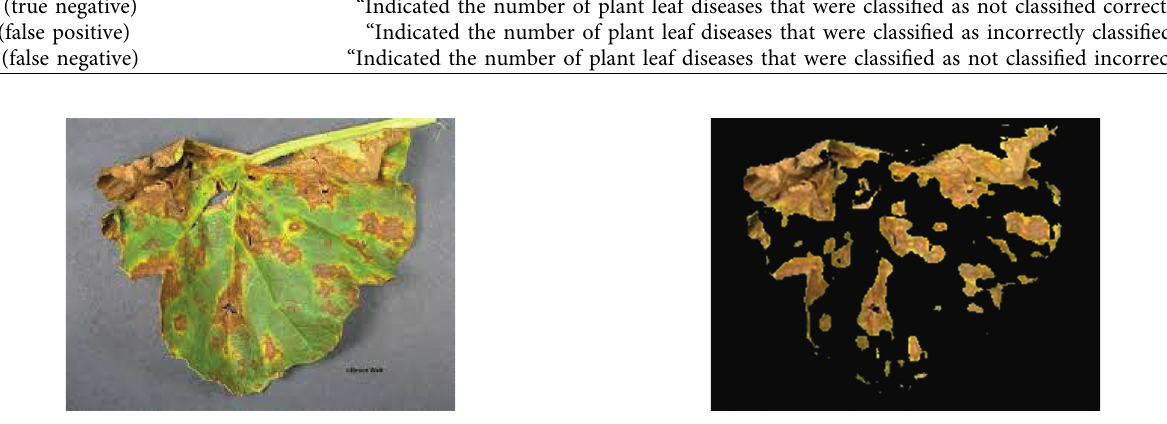
Figure 7: Input image.